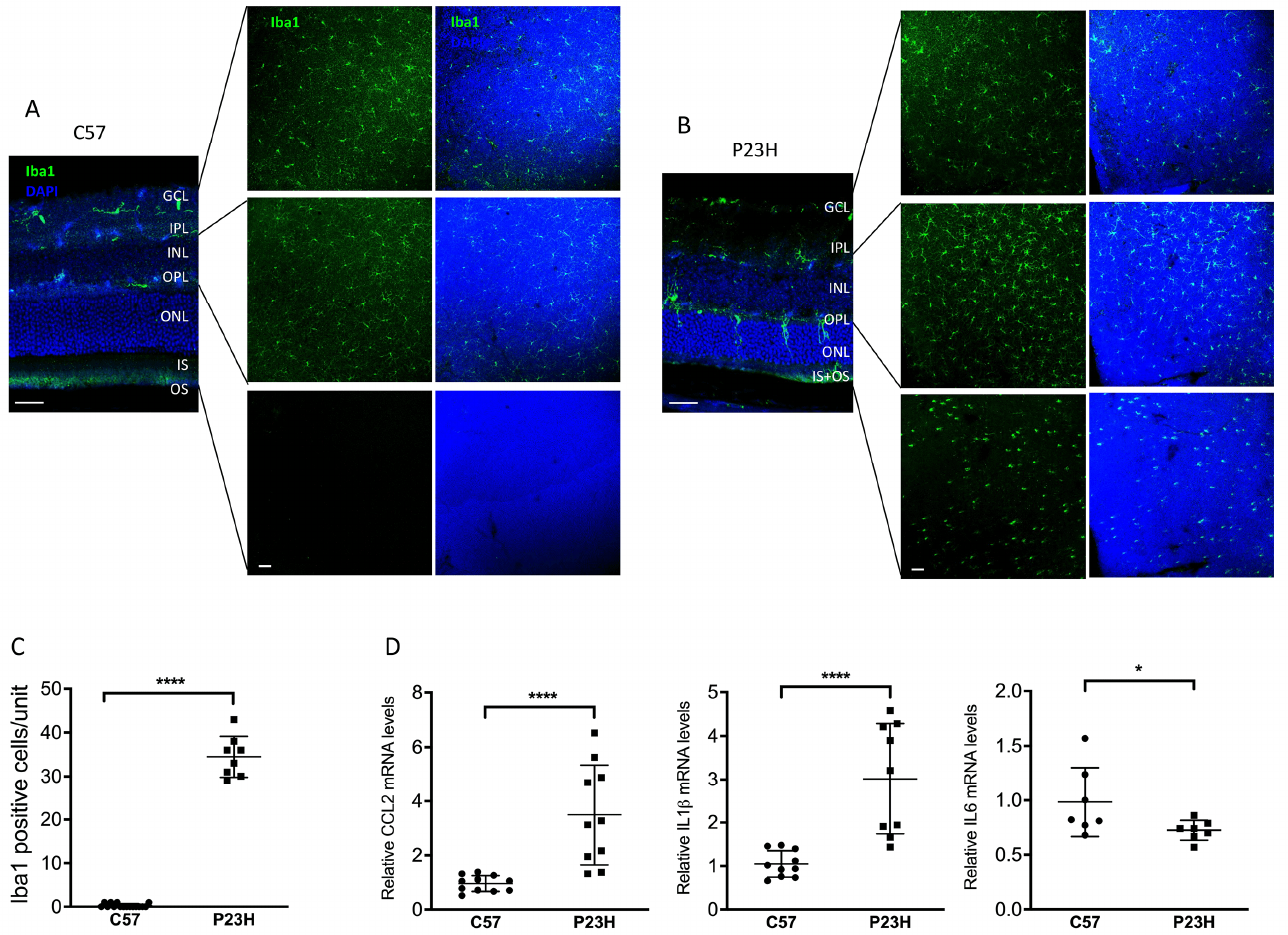
Figure 6. Activated inflammatory cytokines and microglia in the P23H retina. ( A ) Representative confocal images of 30 µ m retinal sections and retinal whole mount of two-month-old C57 and ( B ) P23H mouse stained with Iba1 showing Iba-1 positive cells in different layers of the retina as indicated. Nuclei were counterstained with DAPI. ( C ) Quantification of Iba-1-positive cells in the ONL and subretinal space of the inferior area of the retinal whole mount from P23H and C57 mice. Counting unit is confocal image at 40 × magnification ( D ) Transcript levels of inflammatory cytokines- CCL2, IL1b and IL6 in the retinas of P23H at two months of age, normalized to C57 mice (n ≥ 7). * p < 0.05; **** p < 0.0001; one-way ANOVA. GCL, ganglion cell layer, IPL, inner plexiform layer, INL, inner nuclear layer, ONL, outer nuclear layer; IS/OS, inner and outer segment. Scale bar: 50 µ